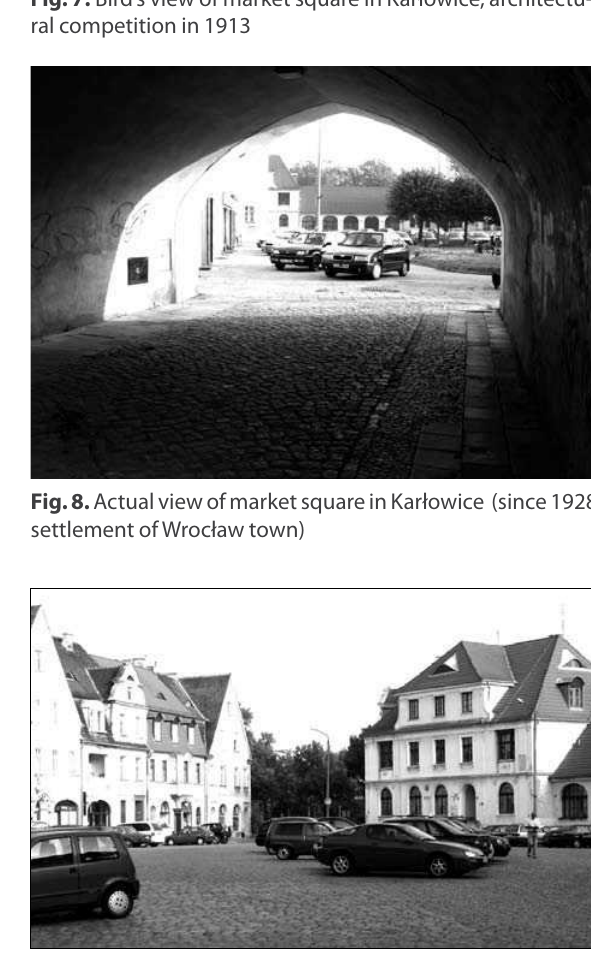
Fig. 9 . Present frontage of market square in